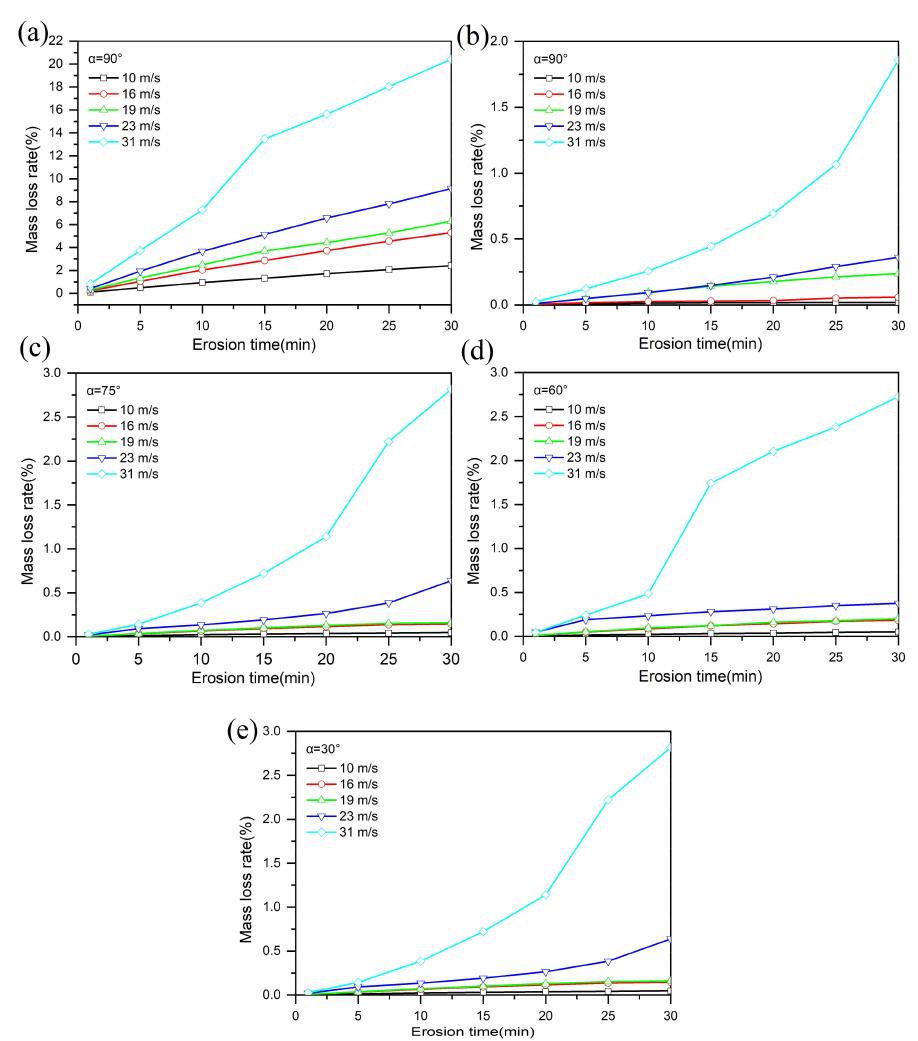
Figure 13. Development curve of sample mass loss rate with wind erosion time: ( a ) remolded soil; ( b ) improved soil; ( c ) improved soil; ( d ) improved soil; ( e ) improved